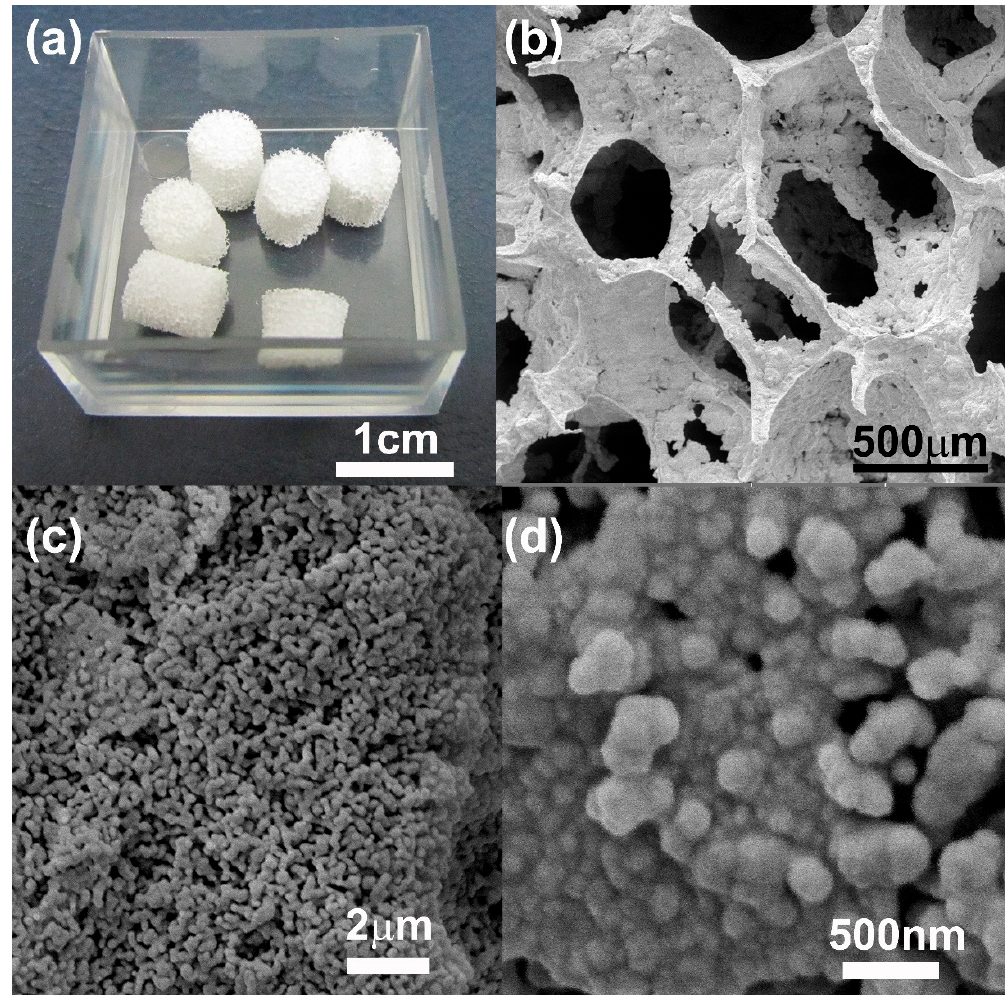
Figure 3. ( a ) 100HA/40 wt.%/1100 ◦ C scaffolds as obtained are shown as representative image of all the fabricated scaffolds; ( b – d ) FESEM micrographs are shown of 100HA/20 wt.%/800 ◦ C scaffolds at different magnifications.